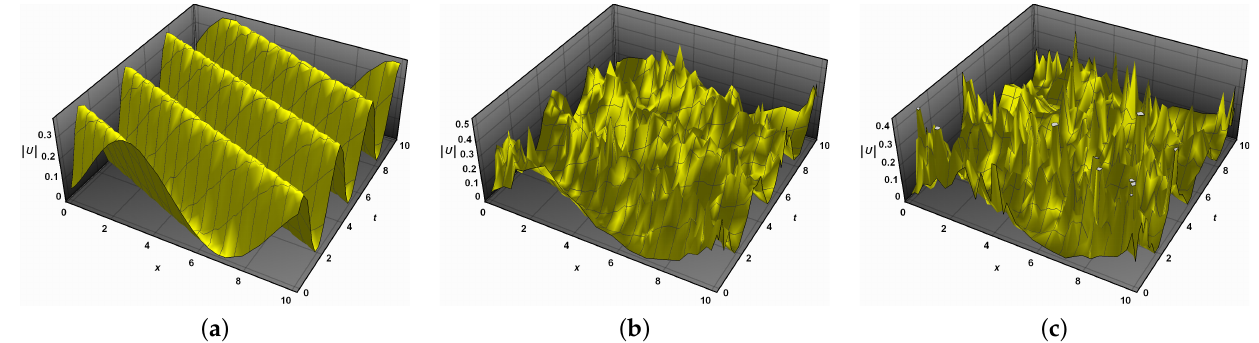
Figure 3. solution (24) for different values of the noise σ and α = 1, y = 0.5 and ( x , t ) ∈ [ 0,10 ] × [ 0,10 ]